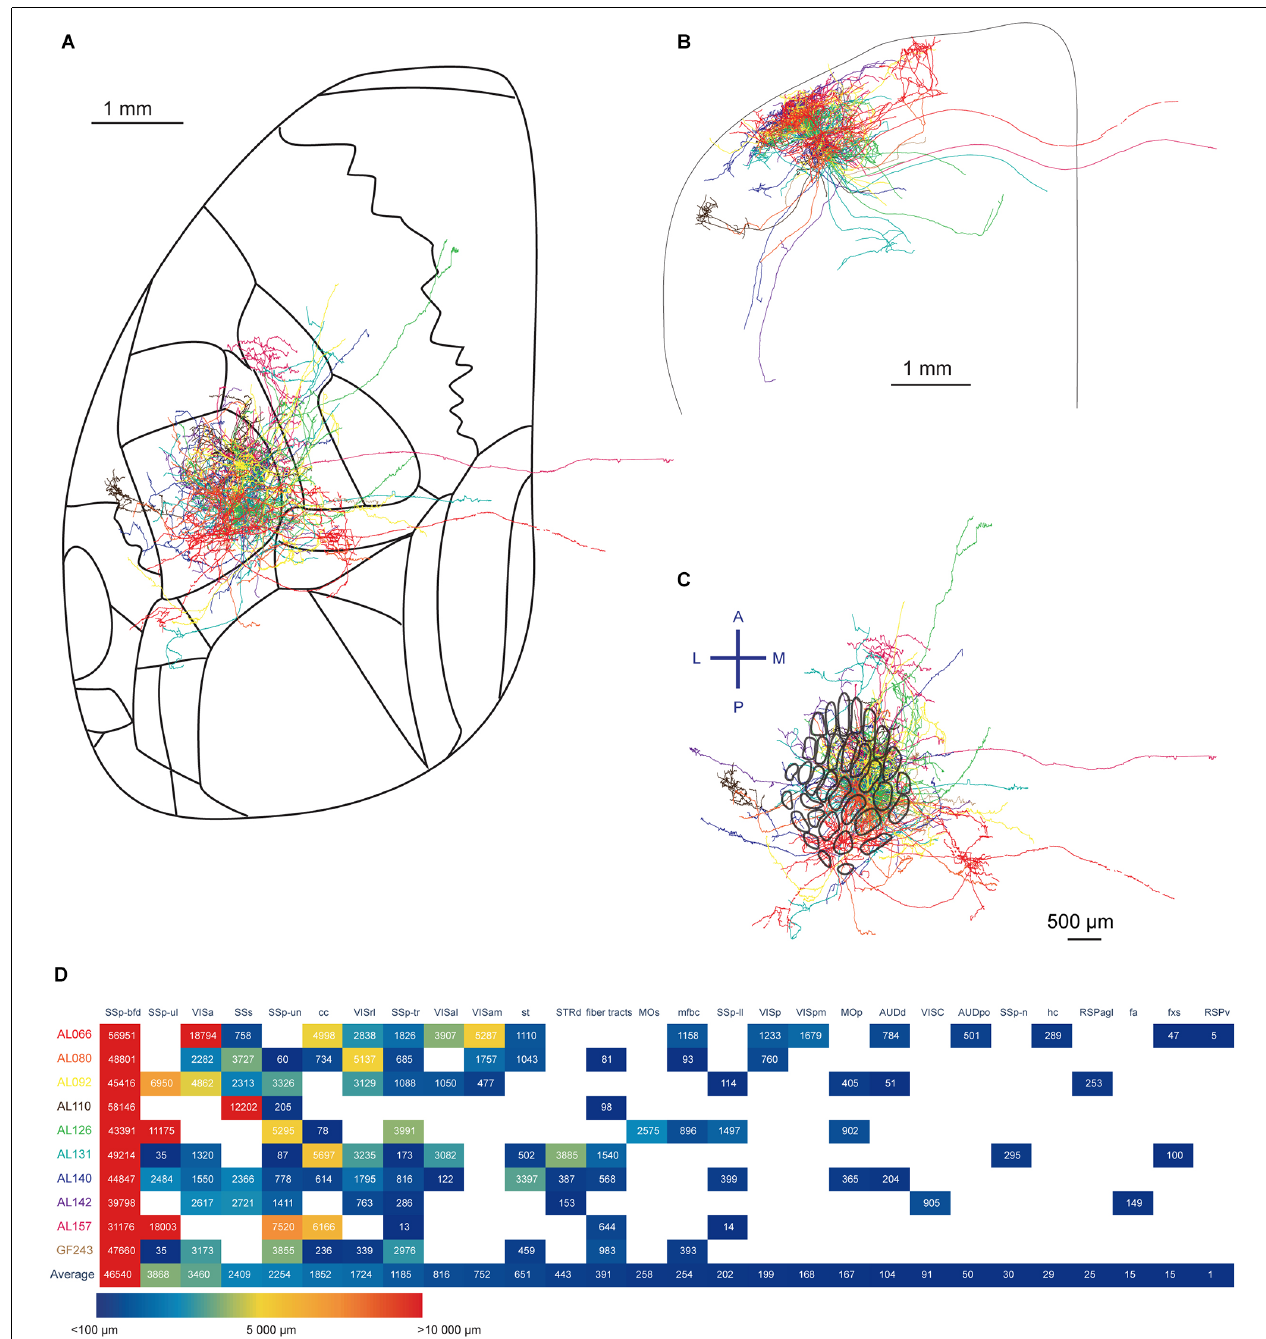
FIGURE 8 | Summary of the ten reconstructed neurons. (A) Horizontal overlay of axons aligned to the Allen Mouse CCFv3. The axon of each neuron is shown in a different color. (B) Coronal overlay of axons. (C) Tangential view of axons aligned to the barrel map. (D) Quantification of axonal length in respective brain regions. The length of the axon in each layer of a specific region is summed up. The different brain regions receiving projections from the labeled neurons are sorted according to the mean length of the reconstructed axon across all neurons in each region of interest, from the longest axonal length on the left to the shortest axonal length on the